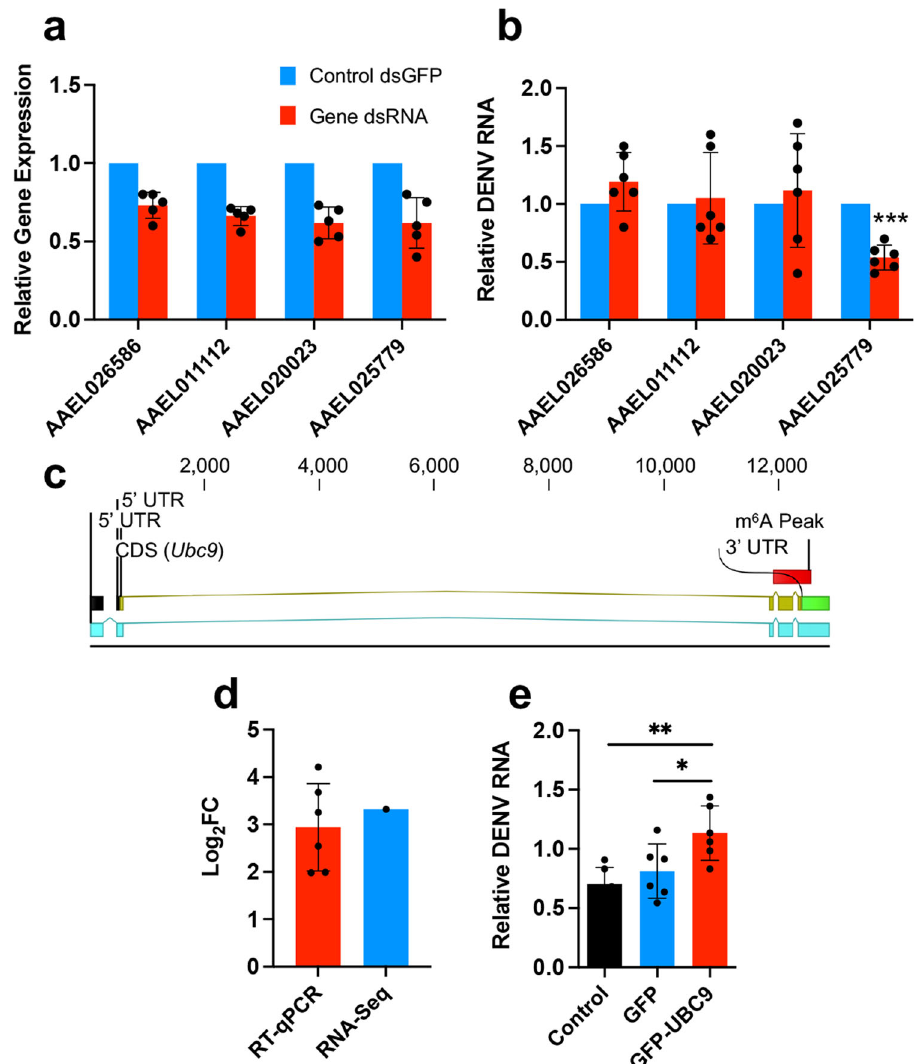
Fig. 7 Ubc9 facilitates DENV replication in Ae. aegypti cells. a Con fi rmation of silencing of four genes selected from differentially expressed genes by RNAi in Aag2 cells. b Inhibition of DENV replication by Ubc9 (AAEL025779) silencing. Aag2 cells transfected with dsRNA targeting GFP or dsRNA targeting the four genes were infected with DENV-2 72 h after transfection. Cells were collected at 72 hpi for quanti fi cation of DENV RNA by RT-qPCR. Control GFP expression levels in a and b were adjusted to 1. *** p < 0.001 ( t -test). c Location of the m 6 A peak in Ubc9 . d RT-qPCR analysis of RNA from Aag2 cells infected with DENV for 72 h showed consistency in up-regulation of Ubc9 transcript levels with the RNA-Seq data. FC, fold change. e Aag2 cells transfected with pSLfa-GFP or pSLfa-GFP-Ubc9 were infected with DENV 72 h after transfection. Cells were collected at 72 hpi for RNA extraction and quanti fi cation of DENV genomic RNA by RT-qPCR. Error bars represent mean ± S.D. * p < 0.05; ** p < 0.01. One-way ANOVA with post hoc comparisons. Dot blot . Total RNA was isolated from Aag2 and Vero cells. RNAs of the EGFP Virus titration . Plaque assay was used to measure virus titre in media as gene were synthesized in vitro by T7 RNA polymerase. Samples were diluted to described previously 44 . Brie fl y, Vero cells (4 × 10 4 in 50 μ l medium) were seeded 100 ng/ μ l and spotted on a polyvinylidene fl uoride membrane (PVDF, Roche, in a 96-well plate and incubated at 37 °C until 90 – 100% con fl uent. Then, col- Indianapolis, IN, USA). The membrane was UV-cross-linked and air-dried. The lected medium containing virus was diluted to 10 0 , 10 − 1 , 10 − 2 , 10 − 3 with membrane was then blocked in the blocking buffer (5% skim milk in PBST) for 2h medium, and added into wells. Plates were fi rst incubated for 1 h with shaking at at room temperature, and incubated with an m 6 A monoclonal antibody (1:1000; room temperature and then incubated for an additional hour at 37 °C. After that, medium was removed from each well and to each well 50 μ l of a mixture of Synaptic Systems) overnight at 4°C. After three washes with wash buffer (5% skim 50% CMC gel (3% carboxymethyl cellulose) + 50% medium with FBS ( fi nal milk in PBST) for 10 min each, the membrane was incubated with an anti-mouse concentration of 4%) was added. The plate was incubated at 37 °C for 72 h. The secondary antibody conjugated with an IR Dye (1:5000; Sigma) for 60 min at room overlay was discarded, then cells were fi xed by adding 50 μ l of ice-cold 80% temperature. After three washes as above, signals were detected with LI-COR acetone in PBS at − 20 °C for 20 min and then air-dried overnight. Five percent Biosciences Odyssey infrared Imaging System and application software. skim milk in PBST (1× phosphate-Buffered Saline, 0.1% Tween) was used to block the cells. Cells were incubated with the primary antibody against DENV-2 Envelope protein (human) in 1:1000 dilution in 0.1% skim milk in 1×PBST for MeRIP-Seq . MeRIP-Seq was carried out by combining and modifying approaches 2 h at 37 °C. After that, the plate was washed three times with PBS containing described previously 16,27 . Aag2 cells seeded in 6-wells plates were infected with 0.05% Tween 20. Subsequently, cells were incubated with a secondary IR Dye DENV serotype 2 East Timor strain (DENV-2 ET300) (MOI 1). At 5 days post- conjugated anti-human antibody (Sigma) with 1% skim milk in PBST (1:5000) at infection, total RNA was extracted using QIAzol lysis reagent (QIAGEN) and treated 37 °C for 1 h. The plate was washed three times with PBS containing 0.05% with TURBO DNase I (Thermo Fisher). Total RNA was fragmented using the RNA Tween 20 and dried for 0.5 h. Virus plaques were detected by LI-COR Bios- Fragmentation Reagent (Thermo Fisher) for 15min. MeRIP was performed using ciences Odyssey infrared Imaging System and application software. EpiMark N 6 -methyladenosine Enrichment kit (NEB). Twenty- fi ve microlitres of COMMUNICATIONS BIOLOGY| (2022) 5:607